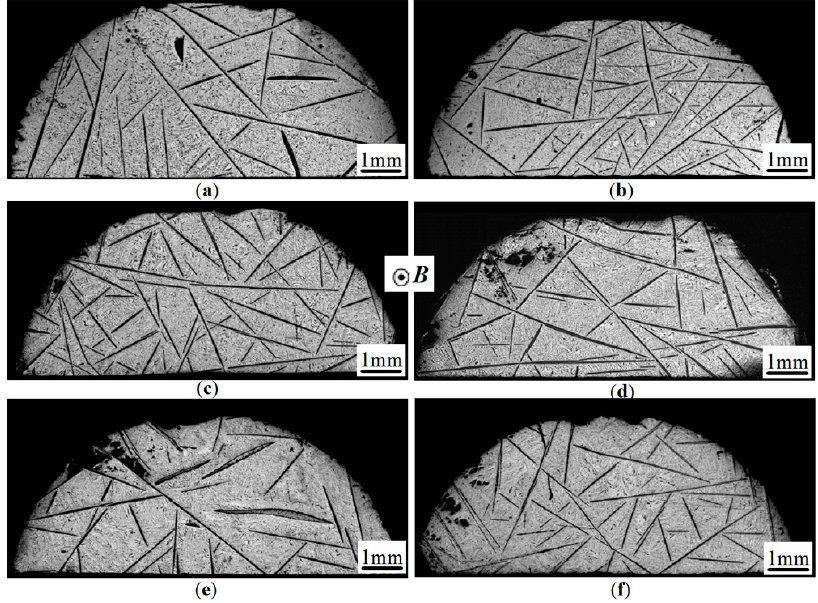
Figure 4. Transverse macrostructures of the specimens under various HMFs: ( a ) 0 T; ( b ) 0.6 T; ( c ) 1.5 T; ( d ) 3 T; ( e ) 5 T; ( f ) 12 T.